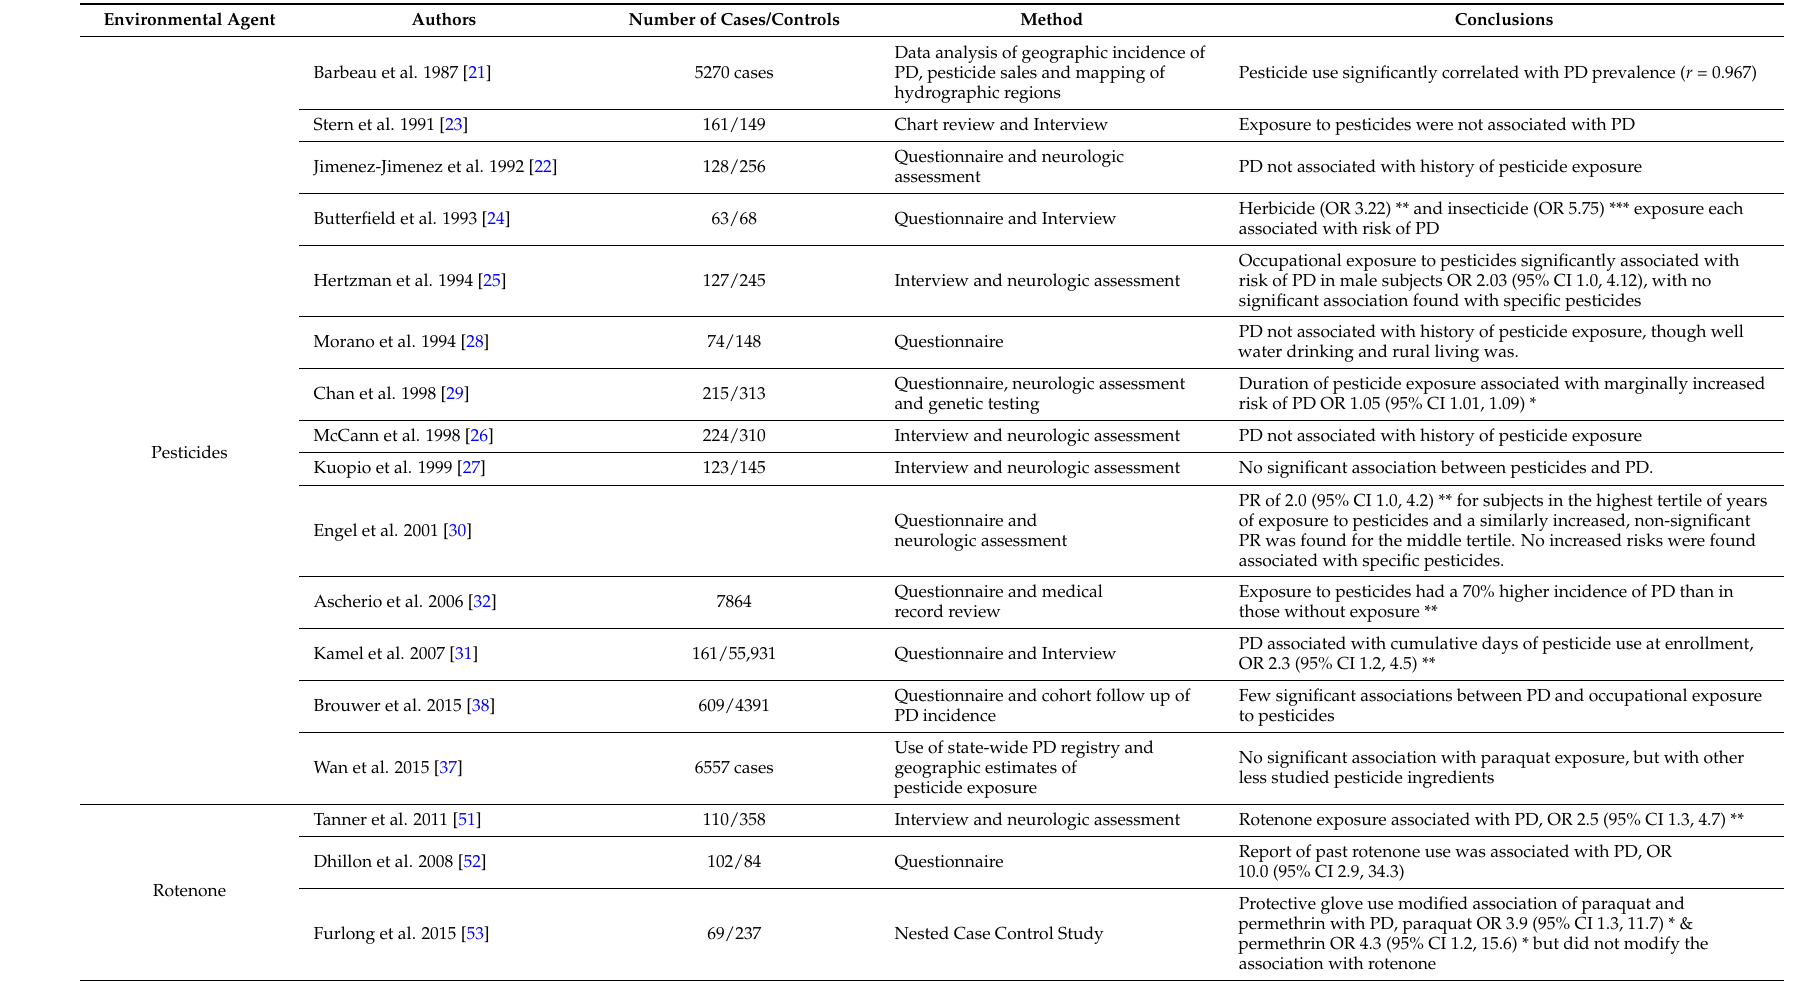
Table 1. Summary of Case-Control Human Studies. Please see separate revised file in online